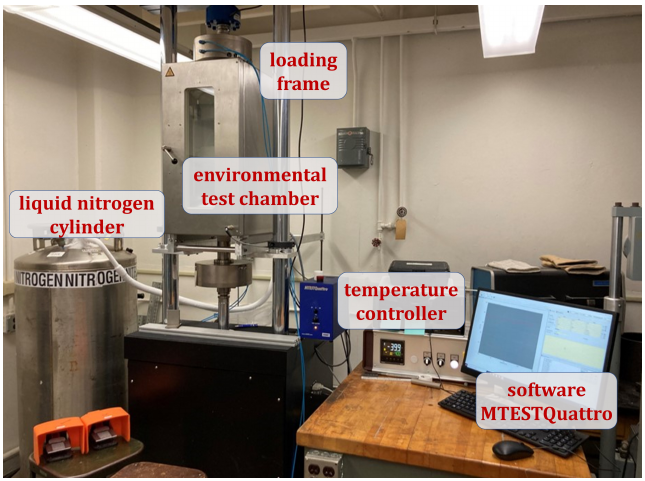
Figure 1. Test apparatus setup for the subzero temperature